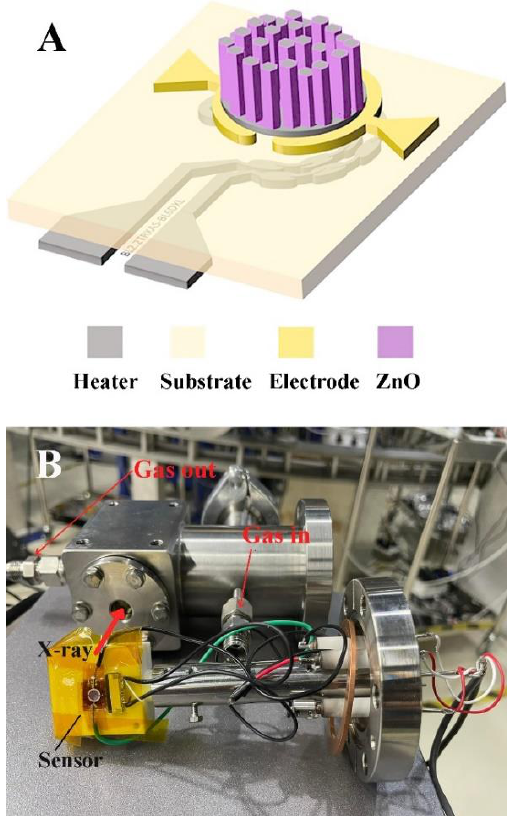
Figure 1. ( A ) Schematic illustration of the ZnO gas sensor and ( B ) the setup of the operando